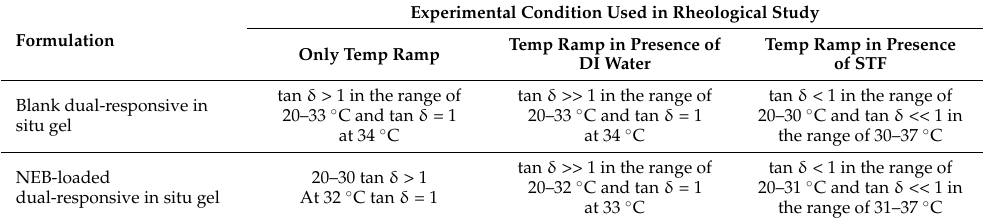
Table 4. Losstangent(tan δ )ofoptimizedblankdual-responsiveinsitugelandNEB-loadeddual-responsive in situ gel as a function of temperature (20 to 37 ◦ C) in presence of STF and deionized (DI) water. Experimental Condition Used in Rheological Study Formulation Only Temp Ramp Temp Ramp in Presence of DI Water Temp Ramp in Presence of STF Blank dual-responsive in situ gel NEB-loaded dual-responsive in situ gel